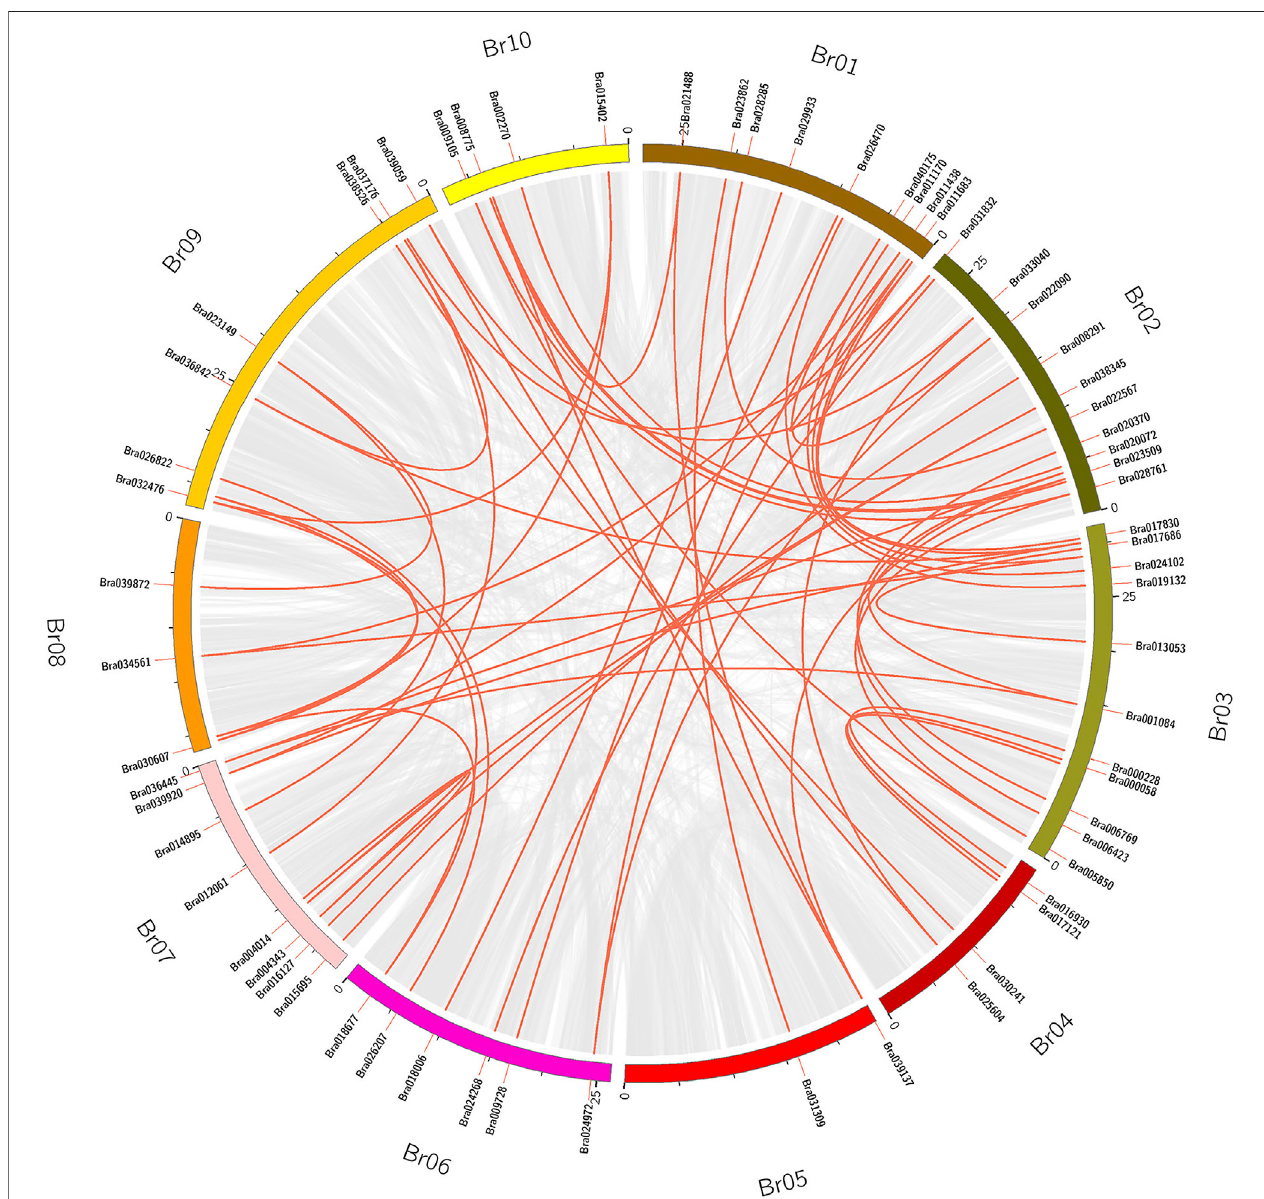
FIGURE 4 | The segmental replication events of BrAPXs in B. rapa . Chromosomes are shown in different colors, with all synteny blocks in the B. rapa genome shown as grey lines and segmental duplication of BrAPX genes shown as red lines, with gene names and chromosome numbers shown outside the diagram.